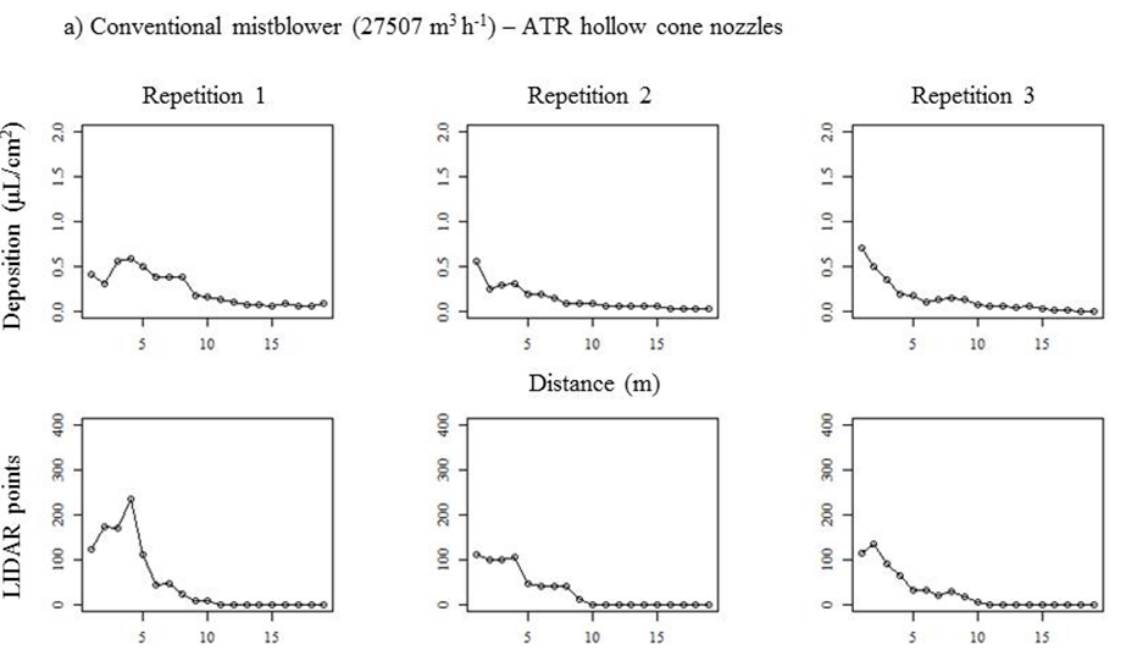
Figure 10. Curves representing deposition of spray deposit (test bench and LIDAR) obtained with conventional mistblower at low air flow rate. Part ( a ) corresponds to conventional hollow cones and part ( b ) corresponds to air injection